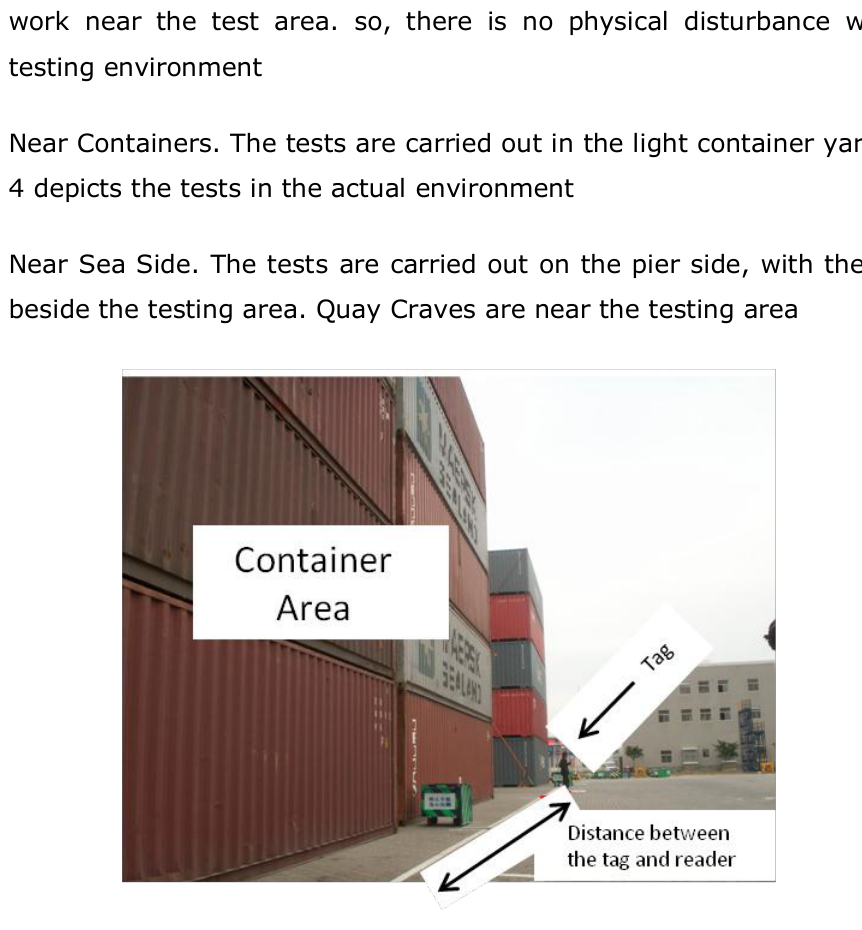
Figure 4. Setup of distant test in containers